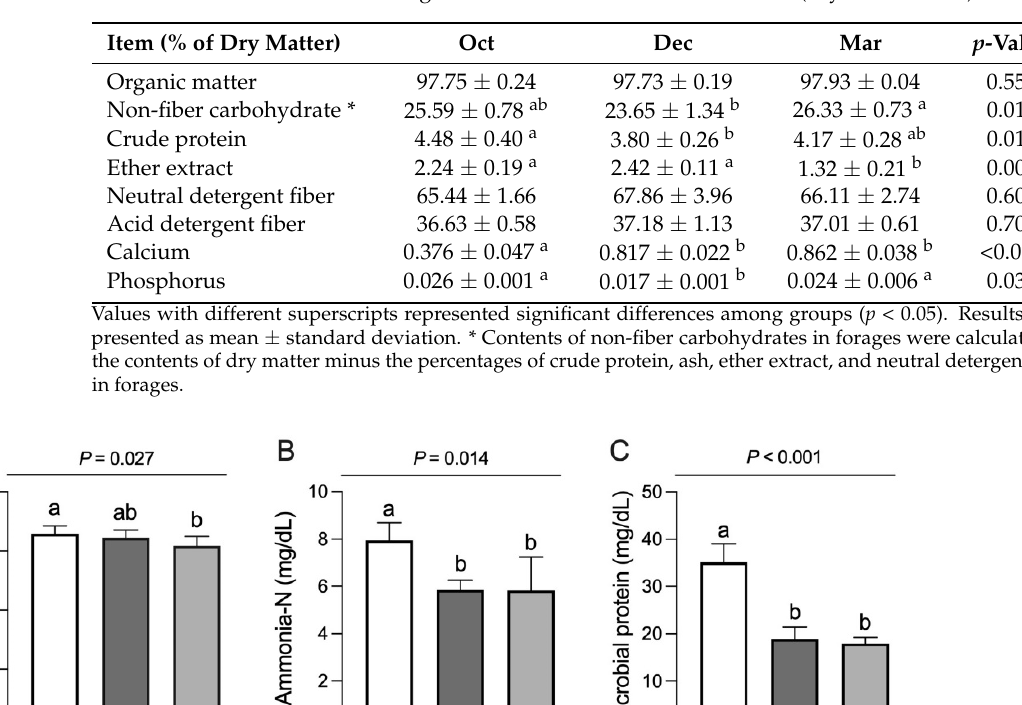
Table 1. Nutritional value of forages in different months of cold season (dry matter basis). Item (% of Dry Matter) Organic matter